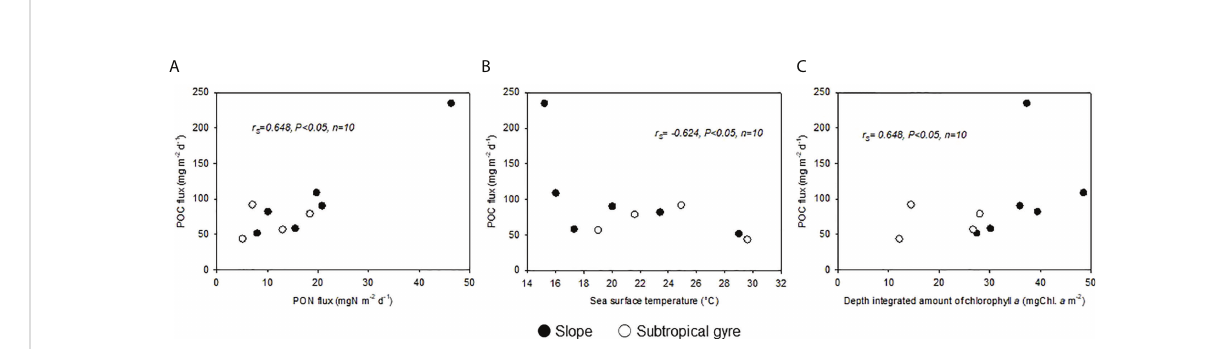
FIGURE 5 Relationships of POC fl ux with (A) PON fl ux, (B) sea surface temperature, and (C) the depth-integrated amount of chlorophyll a Spearman rank order correlations ( r s ) are presented.